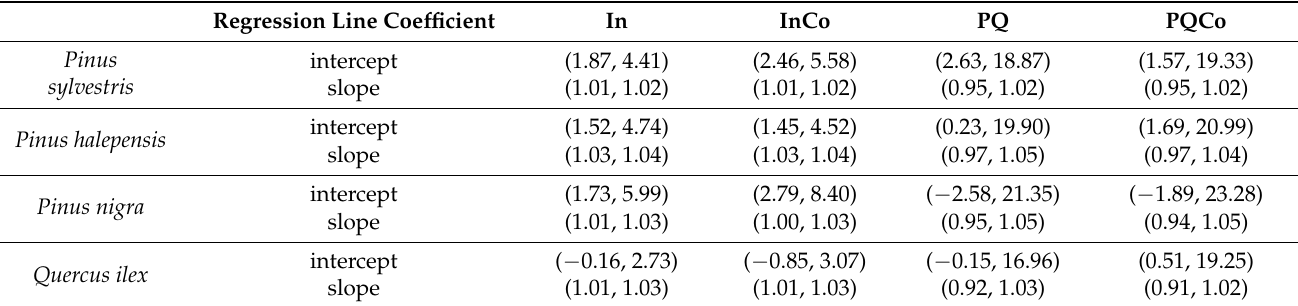
Figure A3. Diagnostic plot (residual vs. fitted values) of the linear model for observed DBH4 vs. predicted DBH4 for the two aggregation levels (individual and plot-quantile classes), Equations (1) and (2), and the four species ( Pinus sylvestris , P. halepensis , P. nigra , and Quercus ilex ). Table A1. Confidence interval at the 95% level for the intercept and for the slope of the linear model between the observed and the expected DBH4 for tracked trees, the two aggregation levels (individual (In) and plot-quantile classes (PQ)), Equations (1) and (2) (Co for competition), and the four species ( Pinus sylvestris , P. halepensis , P. nigra , and Quercus ilex ).